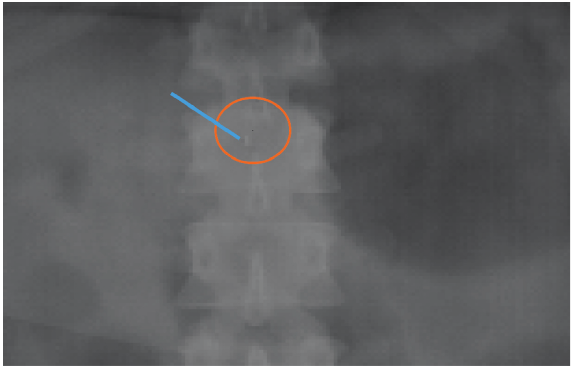
Figure 1: AP lumbar spine radiograph.